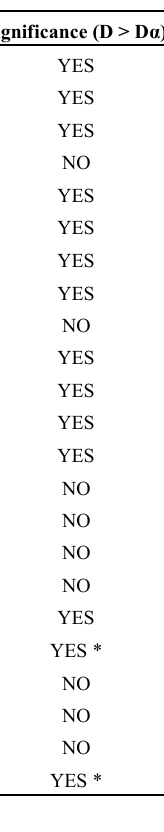
Table 2. Results of Kolmogorov-Smirnov tests on maximum reported densities of all fishes between MPA borders and fished reefs in each of the 23 MPAs surveyed. Tests were conducted at an alpha level (α) of 0.05. Asterisks (*) indicate that a reserve demonstrated a significant shift towards larger body sizes in fished reefs compared to fishes within